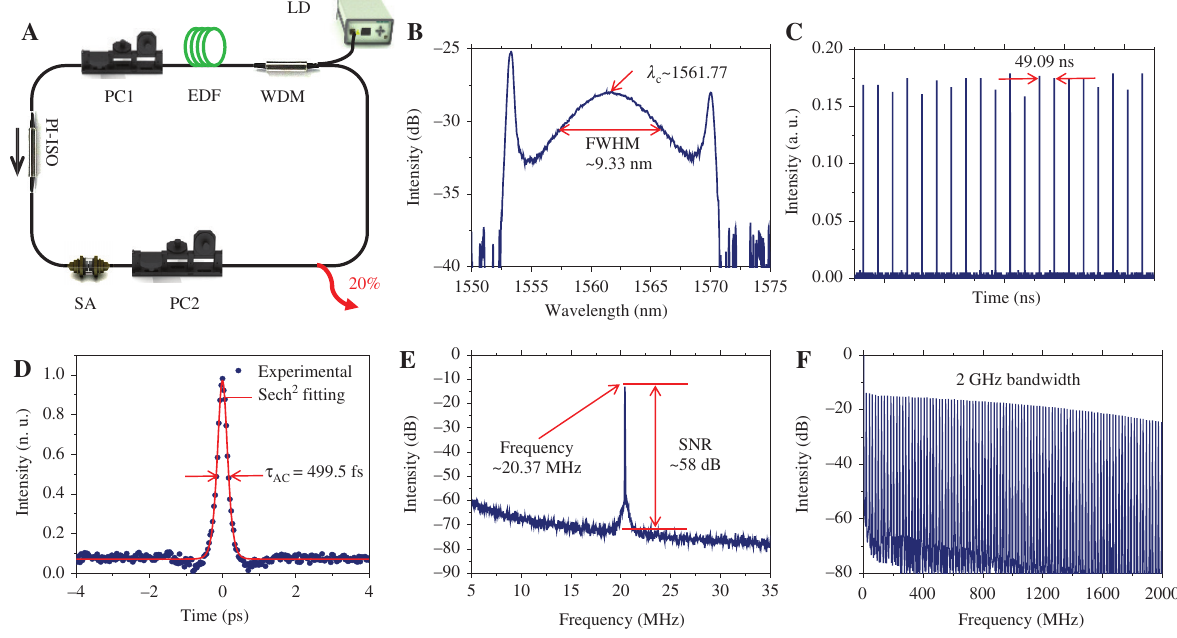
-based mode-locked Er-doped fiber laser. 2